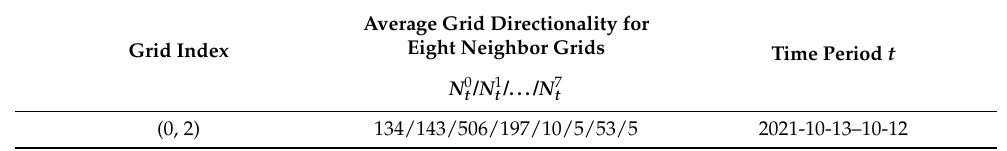
Table 7. Average grid directionalities of Grid s in period t